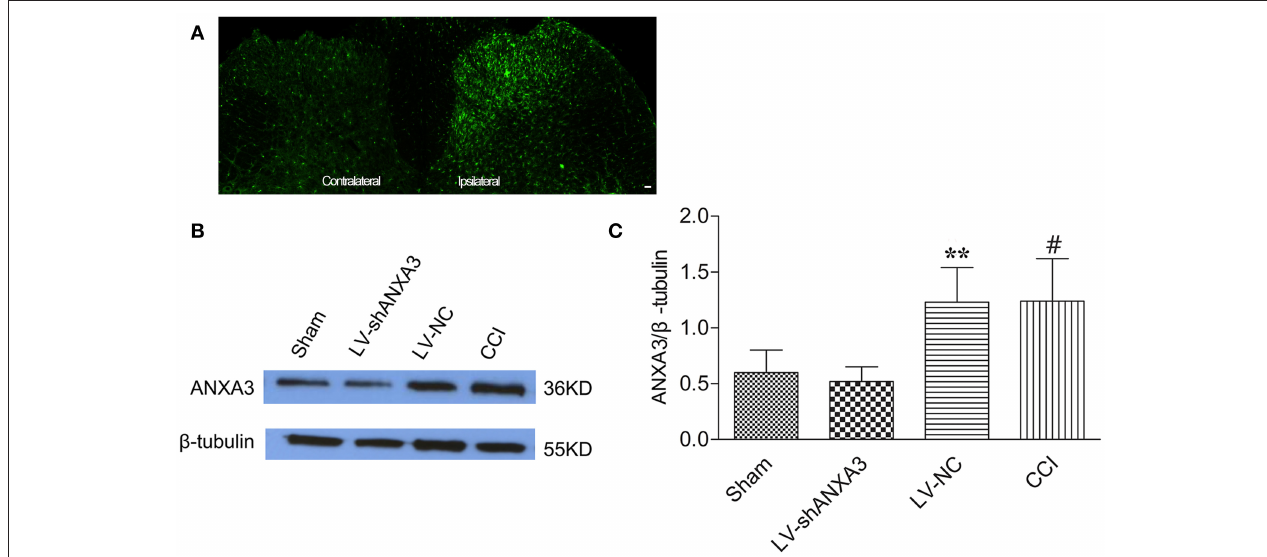
FIGURE 6 | ANXA3 expression in the spinal cord after intrathecal delivery of LV-NC and LV-shANXA3. (A) Staining showed that the expression of ANXA3 in the dorsal horn of spinal cord in the ipsilateral was upregulated compared with the contralateral side. (B,C) Western blot analysis demonstrated that the ANXA3 protein was downregulated by LV-shANXA3 (10 µ l) 7 days after intrathecal delivery in CCI-induced neuropathic pain rats compared with the sham and the LV-NC control rats. β -tubulin was used as the loading control. Each experiment was performed triplicate with indicated number of sample. Significance is defined as ** P < 0.01 compared with LV-NC negative vector control group, # P < 0.01 compared with the sham control group ( n = 5 animals per group).